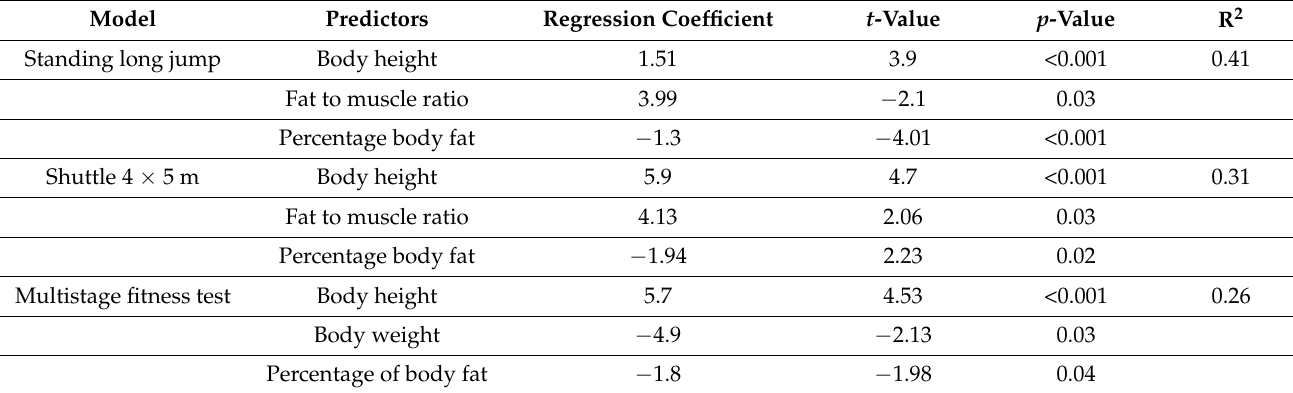
Table 5. The role of anthropometric parameters in physical performances, multiple regression models.